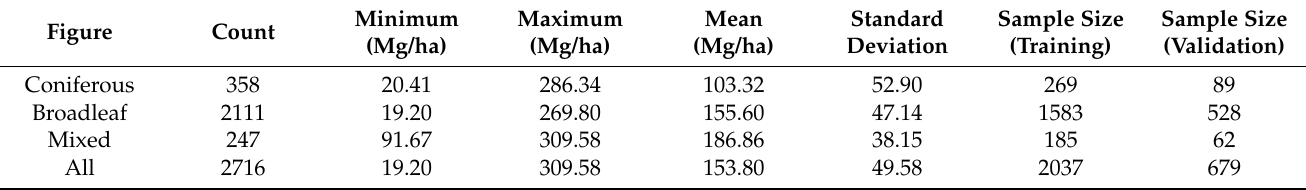
Table 3. Distribution of the plot AGB values (Mg/ha) of the different forest types.